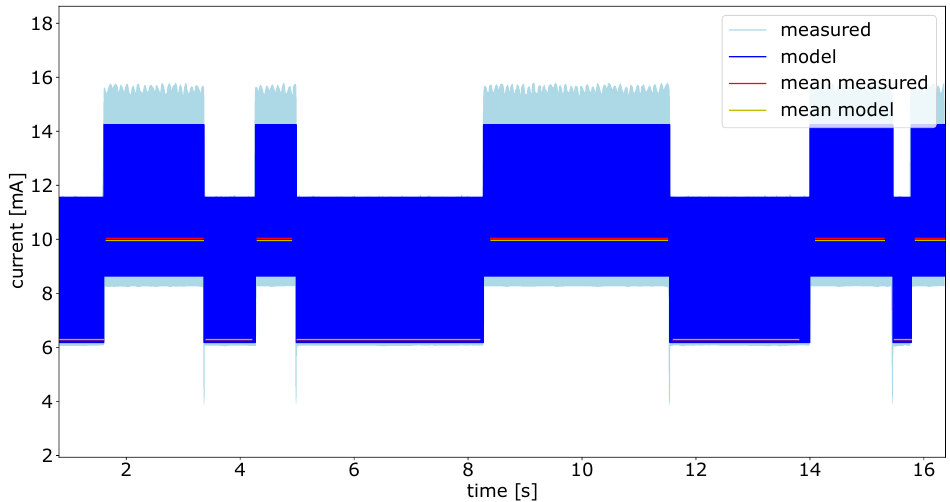
Figure 14. Power values during example test run.